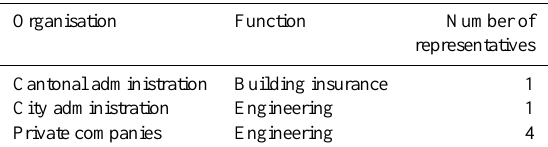
Table 3. Composition of the assessment